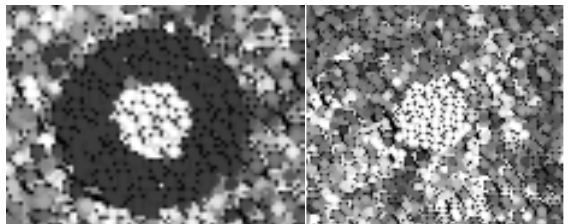
Figure 8. Target T5 (left) and T6 (right) in Flight 1 with point cloud displayed by intensity.